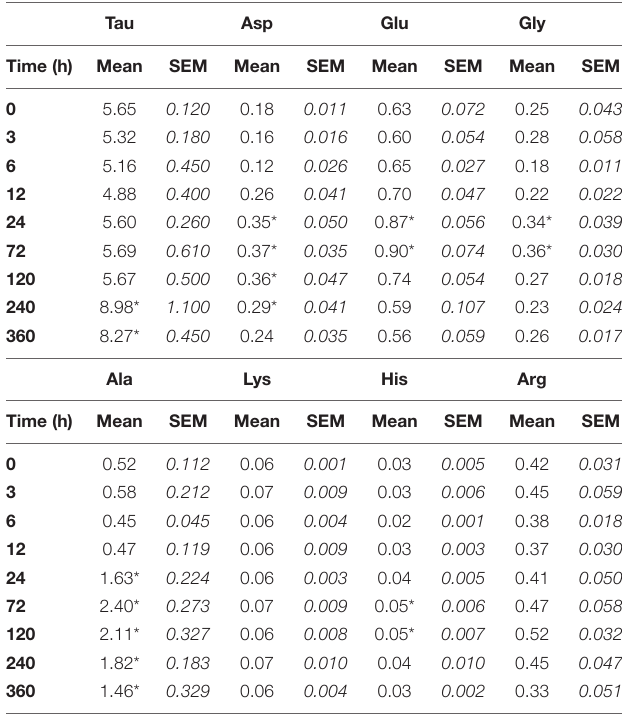
) to seawater (35 ). (cid:104) (cid:104)